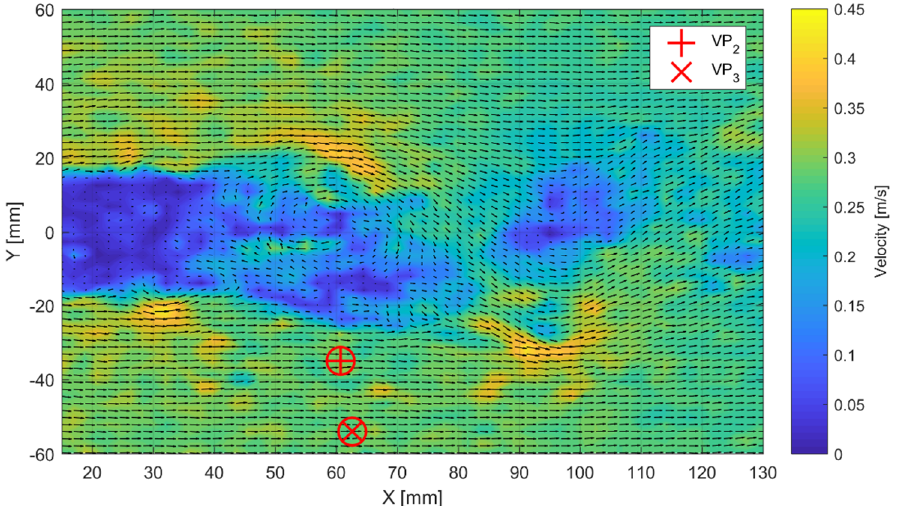
Figure 10. Instantaneous snapshot at t = 1 with additional validation points, VP 1 and VP 2 indicated.